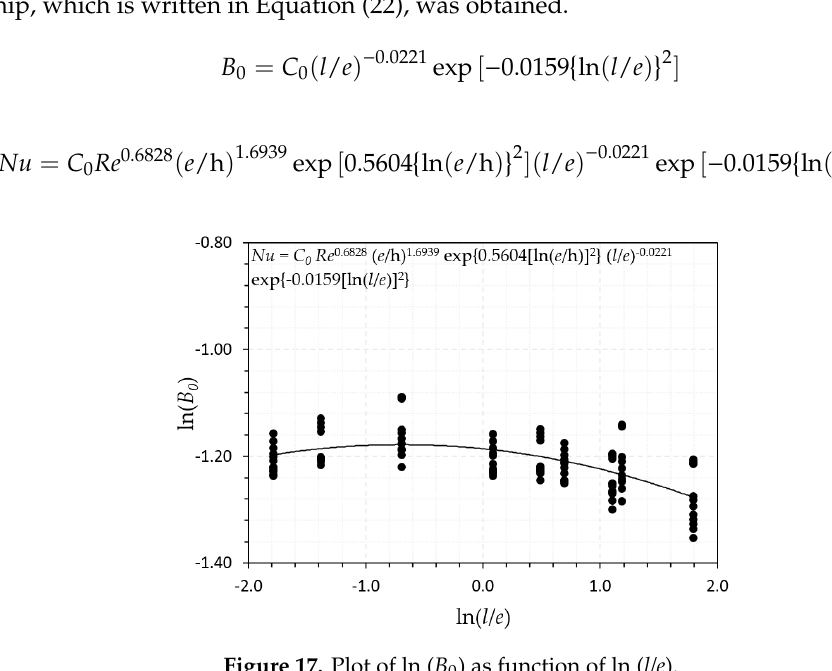
Figure 16. Plot of ln ( 𝐴 (cid:2925) ) as function of ln ( e /h).